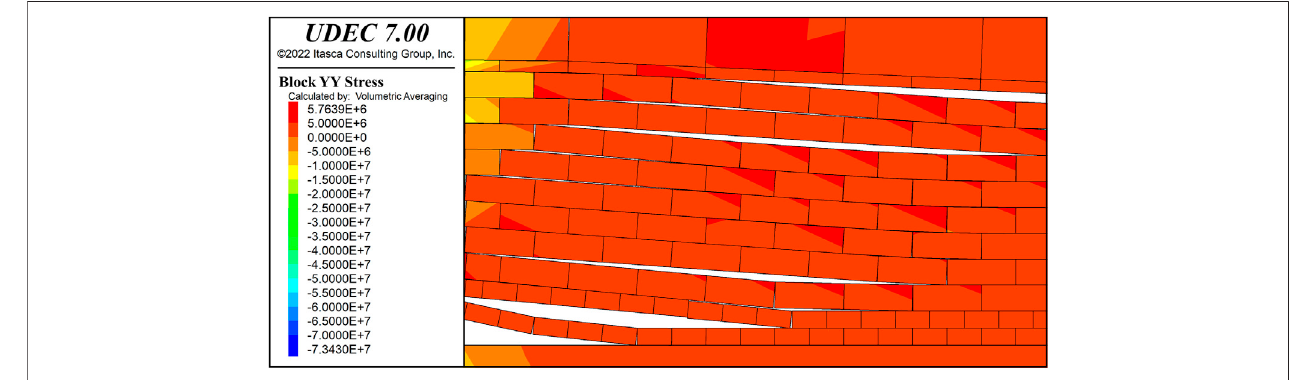
FIGURE 10 | Delamination and rotary instability failure.